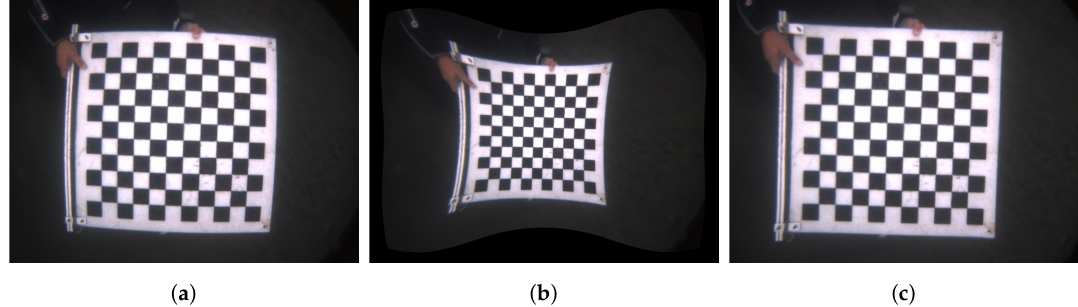
Figure 2. ( a ) underwater raw image; ( b ) rectification based on in-air calibration; ( c ) Pinax rectification based on water salinity and flat-glass panel thickness.